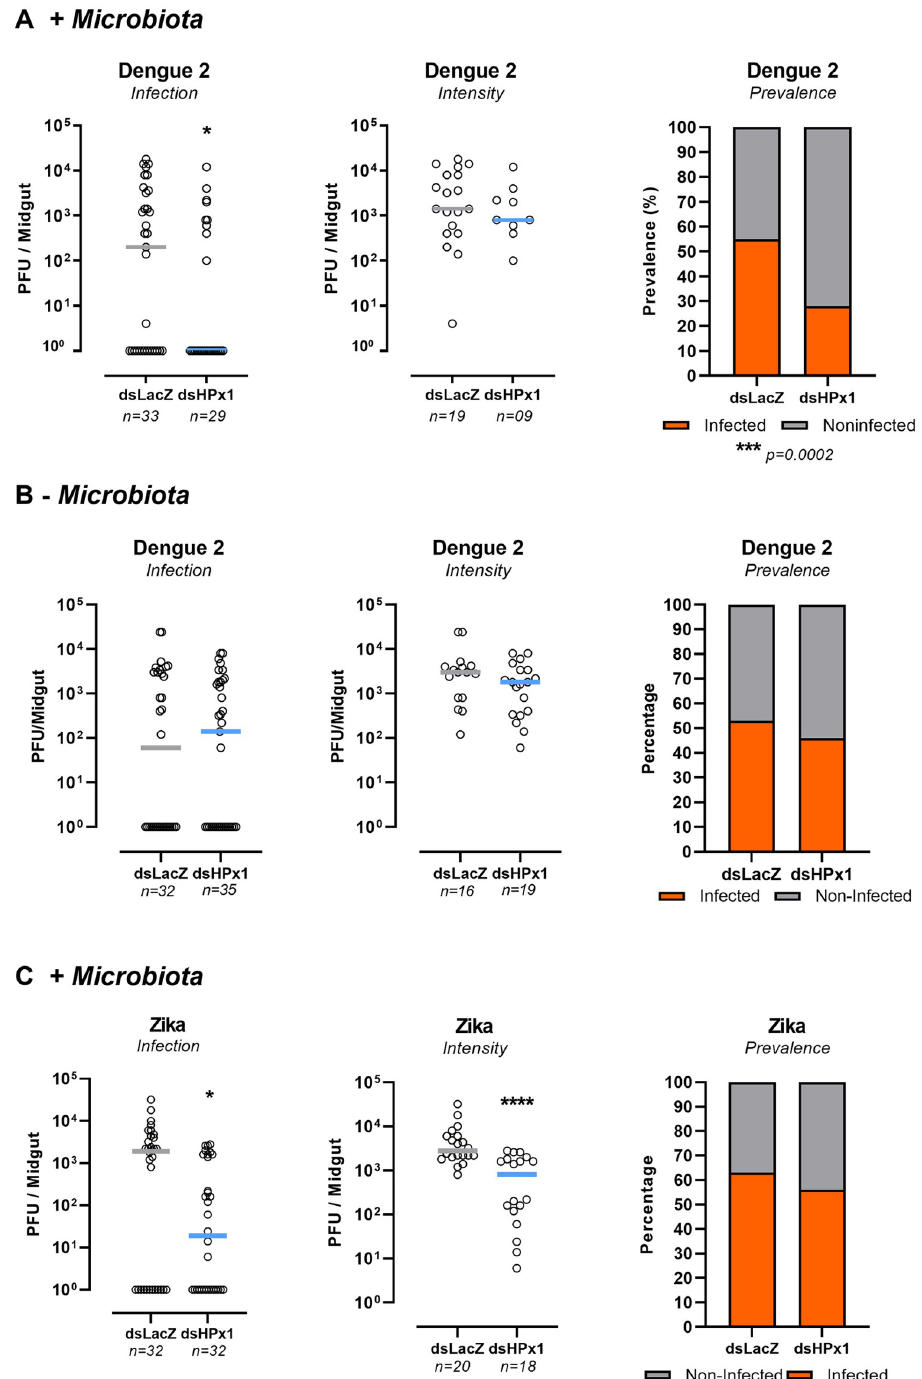
Fig 5. Viral infection in HPx1-silenced insects. A) Dengue 2 titers in midguts 7 days postinfection. B) Mosquitoes were treated with anitbiotics in sugar solution 3 days prior of DENV2 infection. Titers in midguts at 7 days postinfection. C) Zika titers in midguts at 4 days postinfection. Viral titers were assessed by the plaque assay. Each dot represents an individual mosquito gut, and bars indicate the median. � p < 0.05; Mann–Whitney test for A and B. The prevalence statistical analysis was performed by the Chi-square test followed by Fisher’s exact test.